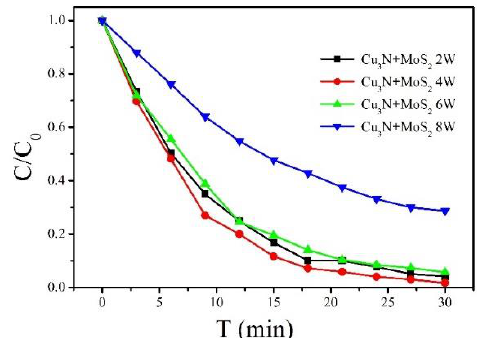
Figure 6. Change in concentration in photocatalytic degradation of methyl orange solution by Cu 3 N/MoS 2 composite films with different sputtering powers.